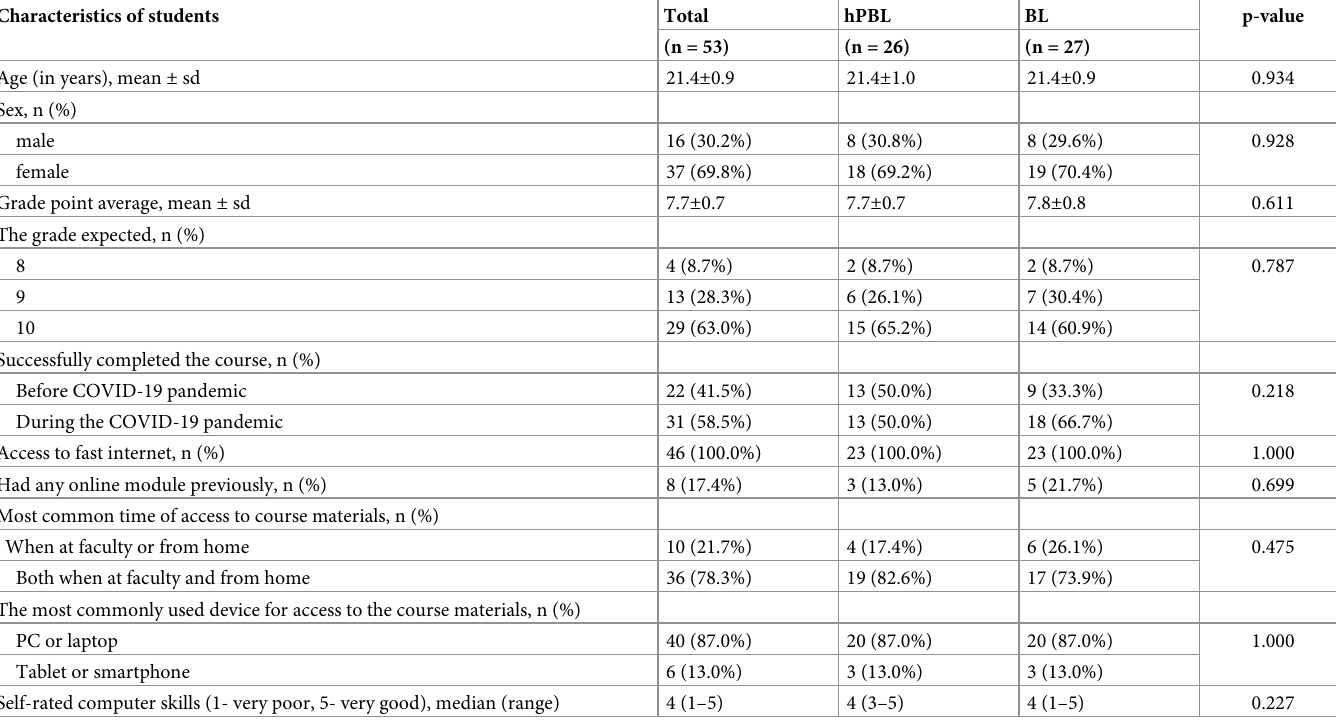
Table 2. Characteristics of students included in the research.